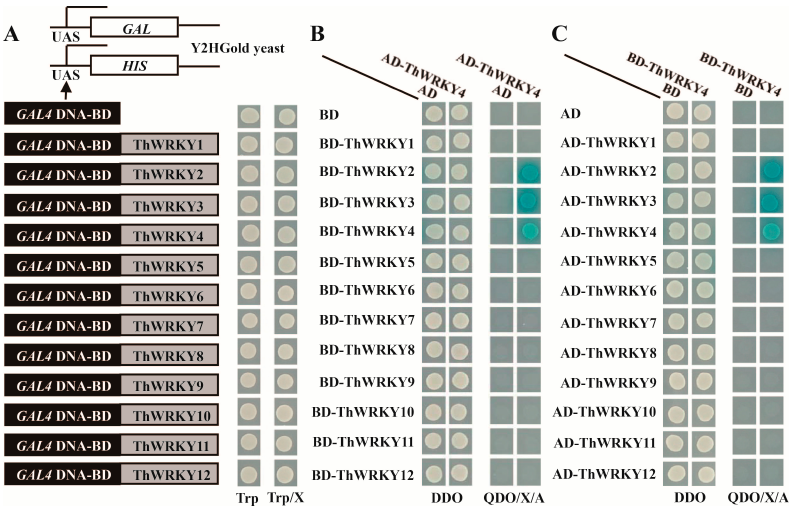
Figure 1. Yeast two-hybrid (Y2H) analysis of the dimerization of ThWRKY4. ( A ) Diagram of the ThWRKYs that were fused to the GAL4 DNA binding domain in the yeast pGBKT7 vector. The transformed yeast culture was dropped onto SD/–Trp plates with X- α -Gal (Trp/X) to investigate transcriptional activation; ( B , C ) Protein interactions in yeast two-hybrid systems. Twelve ThWRKY proteins were individually fused to the GAL4 DNA-AD domain in pGADT7 following the above manner. The Y2HGold yeast cells were co-transformed with the indicated plasmids and dropped onto SD/–Leu/–Trp (DDO) and SD/–Ade/–His/–Leu/–Trp/X- α -Gal/Aureobasidin A (QDO/X/A) plates to examine growth at 30 °C for 3–4 days.